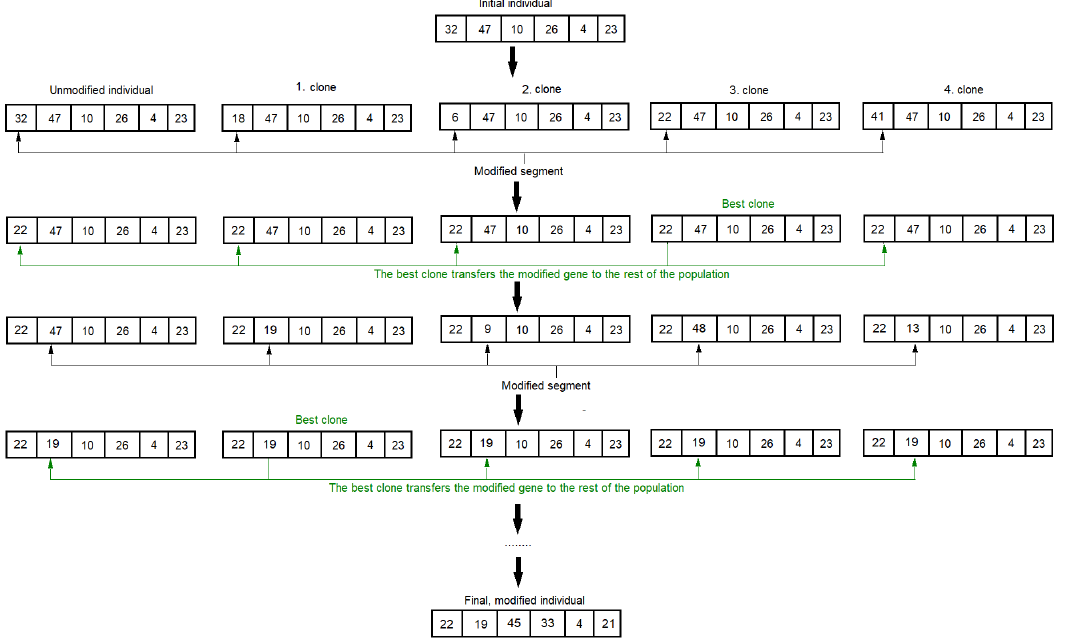
Figure 10. Illustration of a bacterial